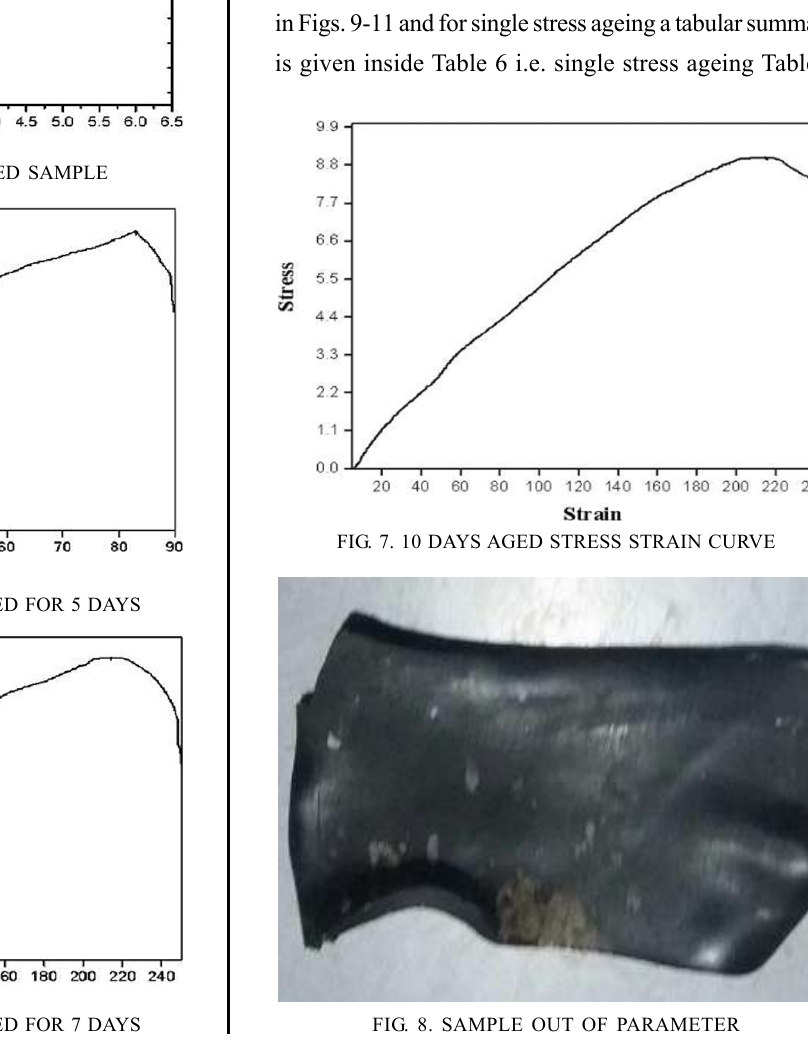
FIG. 4. UT’S CURVE OF UN-AGED SAMPLE